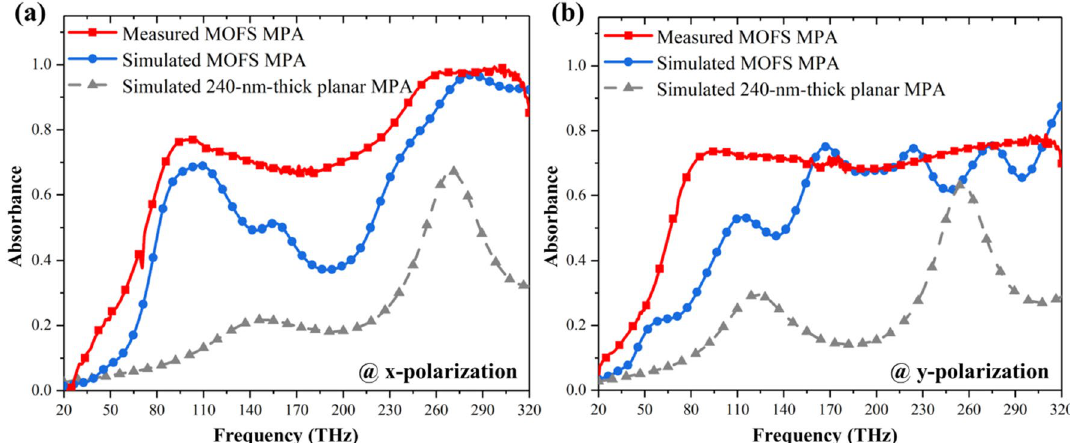
Figure 8. Absorbance of MOFS MPA for ( a ) x- and ( b ) y-polarization. Simulated absorbance of the planar MPA is also included for comparison. Measured and simulated absorbance of MOFS MPA follow the similar trend and outweigh the one of the planar